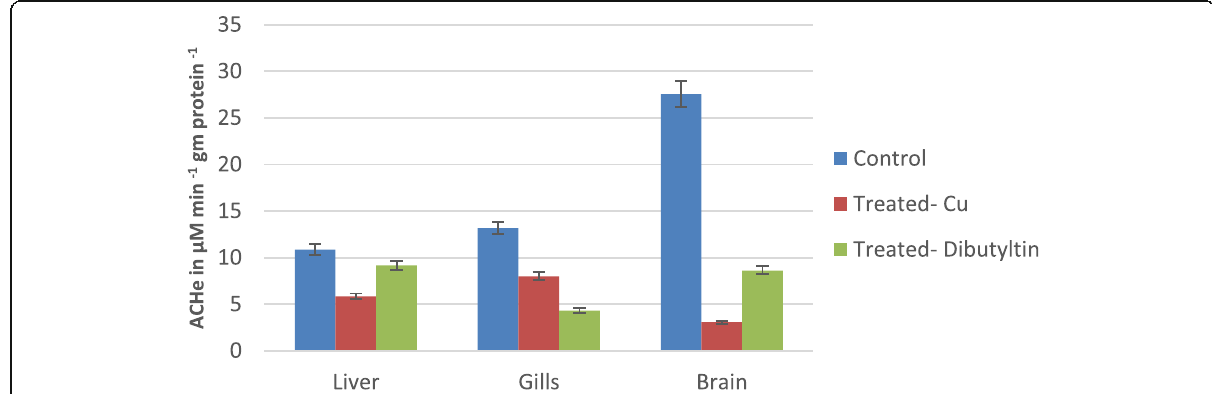
Fig. 6 Average AChE content in tilapia in the liver and gills in control, Cu-treated, and dibutyltin-treated. Data were expressed as mean and